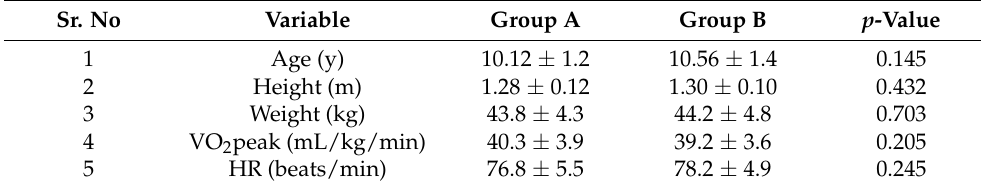
Table 1. Demographic and clinical characteristics of Group A and B.